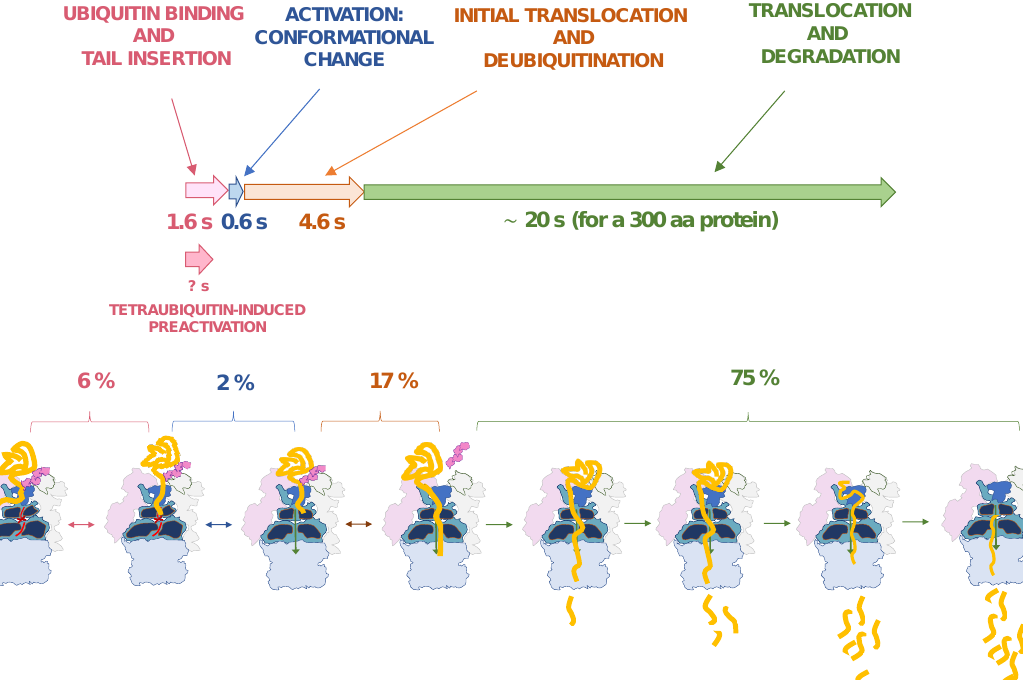
Figure 2. Dynamic representation of protein degradation by the proteasome. Steps described in the text are shown in di ff erent colors, on top, and the information related to each phase is represented in consistent color patterns. Arrows indicate times assigned for each step, based on Bard et al. 2019 [14], adapted to a hypothetical 300 amino acid proteins. The length of the arrows is proportional to estimated times. Percentage numbers indicate the fraction of the total processing time invested in each step. Cartoons representing each step are included